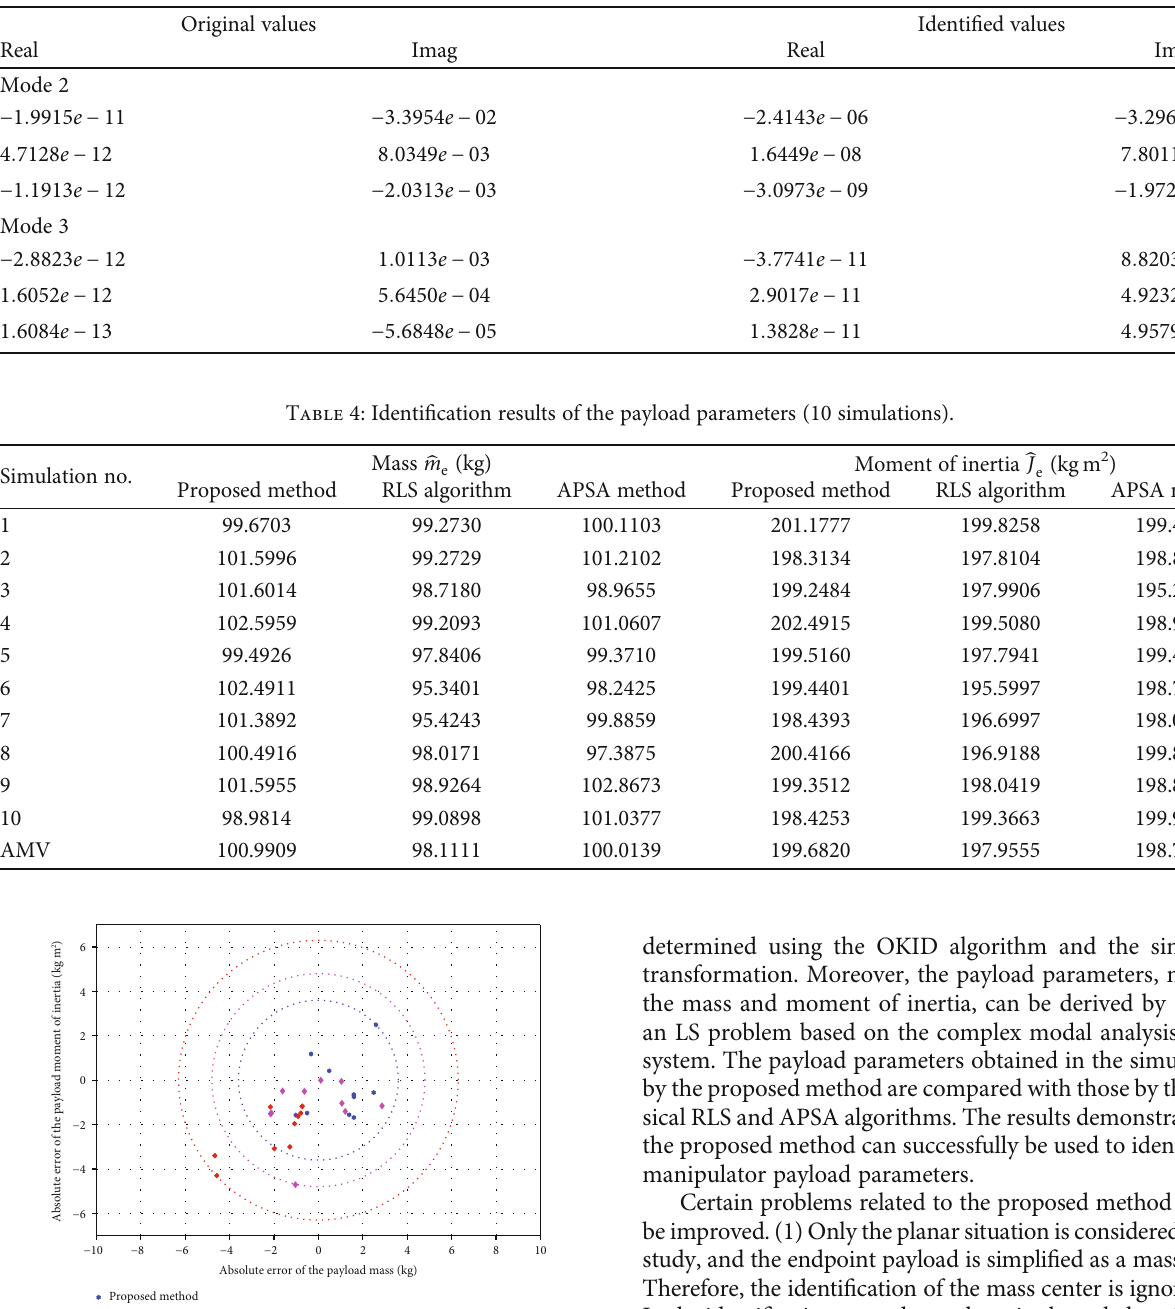
Table 2: Average values of system complex eigenvalues λ